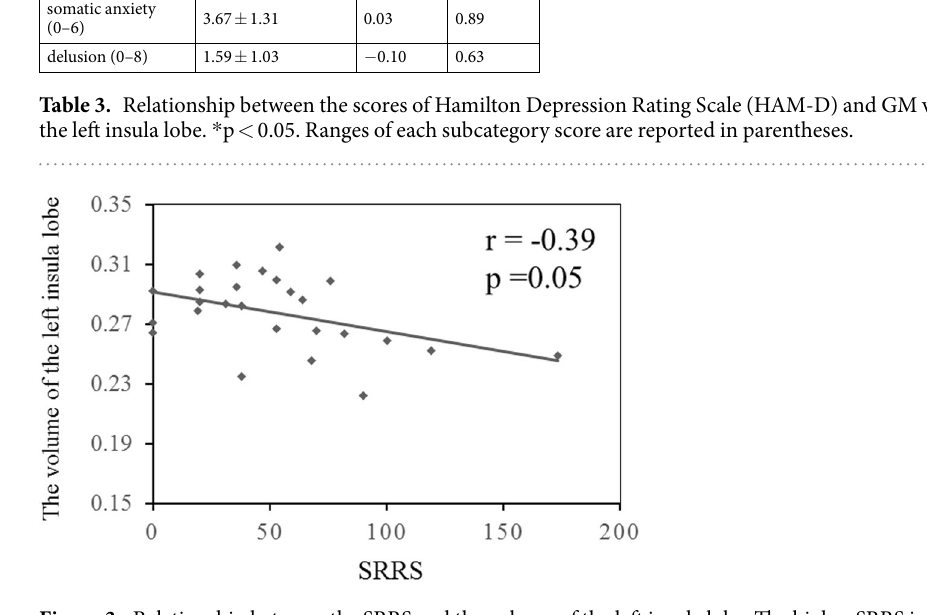
Figure 3. Relationship between the SRRS and the volume of the left insula lobe. The higher SRRS is associated with the volume reduction of the left insula lobe (Spearman rank correlation: uncorrected-p = 0.05, R = −